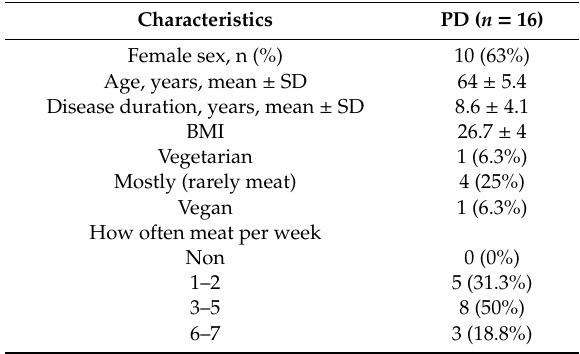
Table 2. Demographic data and characteristics of patients with therapeutic intervention (the given data are complete for all